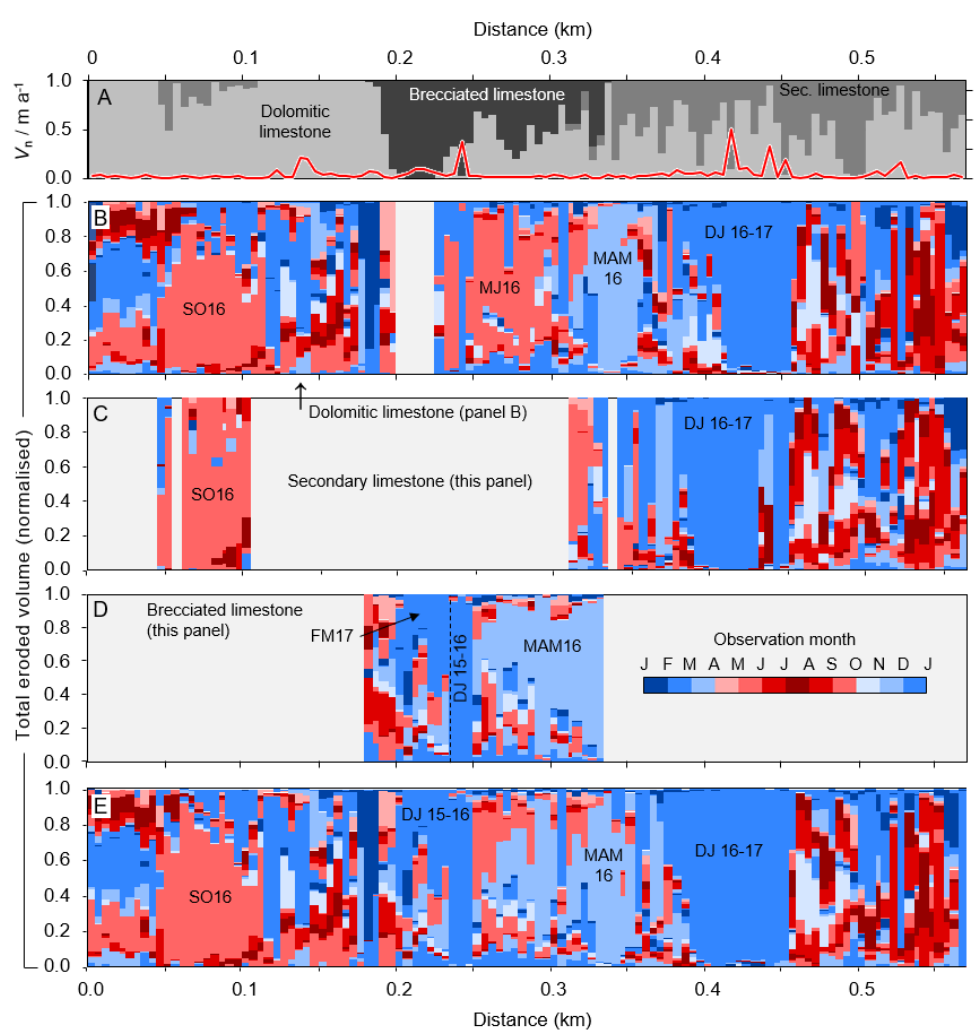
Figure 6. Cross-shore, lithology-specific spatiotemporal erosion cycling. ( A ): Percentage of total erosion attributable to each cliff geology ( V n ) for 5 m cliff line bins. Red line is annual erosion rate (m a − 1 ). ( B – E ): Combined spatial and temporal distribution of rockfall activity for all lithologies ( B ) and the dolomitic, secondary, and brecciated limestones, respectively ( C – E ). Vertical axis is normalized eroded volume per 5 m cliffline bin. Text annotation highlights notable periods of activity (i.e., SO16 = September–October 2016). Red-blue color ramp in ( B – E ) relate to the time of year. Broadly speaking, blues and reds equate to ‘winter’ and ‘summer’ erosion, respectively.